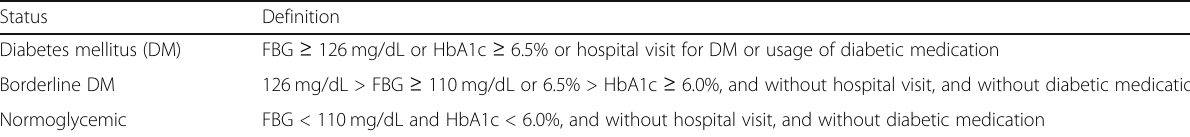
Table 1 Definition of glucose tolerance